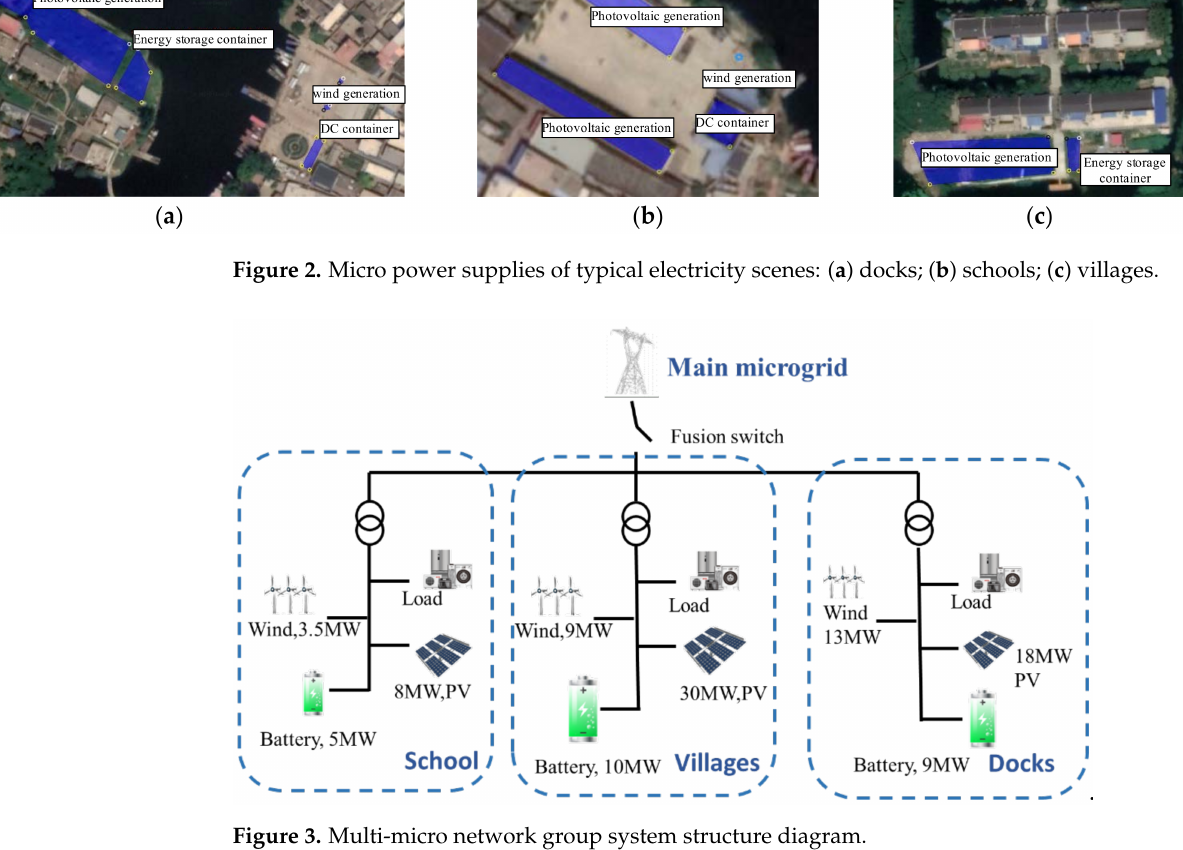
Figure 3. Multi-micro network group system structure